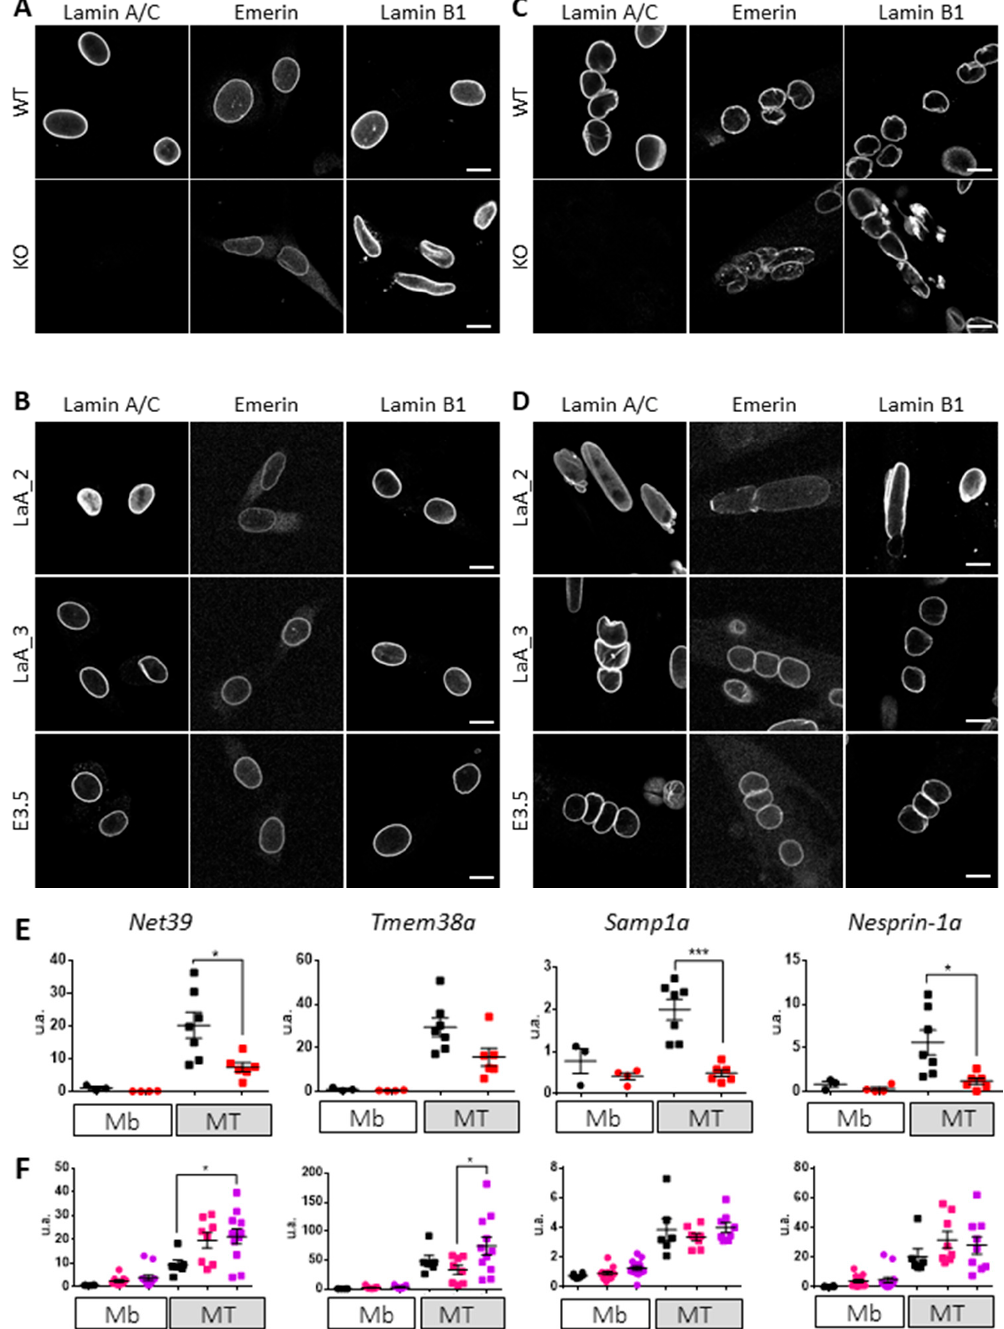
Figure 4. Analysis of the phenotype of Lmna -KO and DARPin expressing myoblasts. ( A , B ) Confocal images showing mouse primary myoblasts ( A ) and myotubes ( B ) derived from WT and Lmna -KO mice immunostained for Lamin A / C, Emerin or Lamin B1. Bar graph: 10 µ m. ( C , D ) Confocal images showing mouse primary myoblasts ( C ) and myotubes ( D ) derived from WT mouse stably expressing LaA_2-, LaA_3- and E3.5-DARPin immunostained for Lamin A / C, Emerin or Lamin B1. Bar graph: 10 µ m. ( E , F ) Dot plots showing Net39 , Tmem38A , Samp1a and Nesprin - 1 α mRNA level in myoblasts (Mb) and four-day di ff erentiated WT (black; at least n = 3) and Lmna -KO (red; at least n = 4) myotubes (MT) normalized to Rplp0 expression. *: p < 0.05; ***: p < 0.001 ( E ) or in myoblasts (Mb) and four-day di ff erentiated E3.5- (black; n = 6); LaA_2- (pink; at least n = 8), LaA_3-DARPin (purple; at least n = 11) and myotubes (MT) normalized to Rplp0 expression. *: p < 0.05 ( F ).